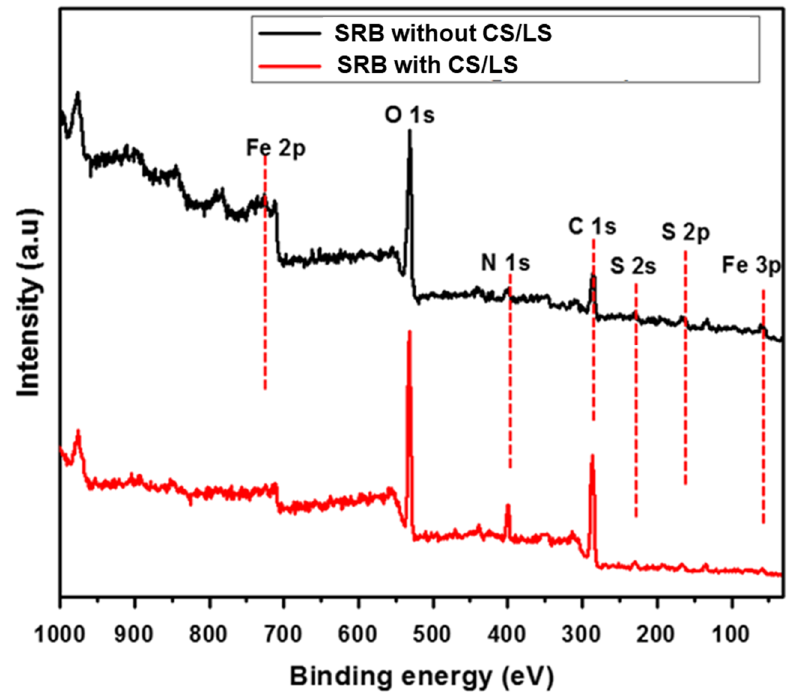
Figure 5. XPS survey spectra of the coupon surface incubated in SRB enriched media with and without CS/LS after 35 days incubation.